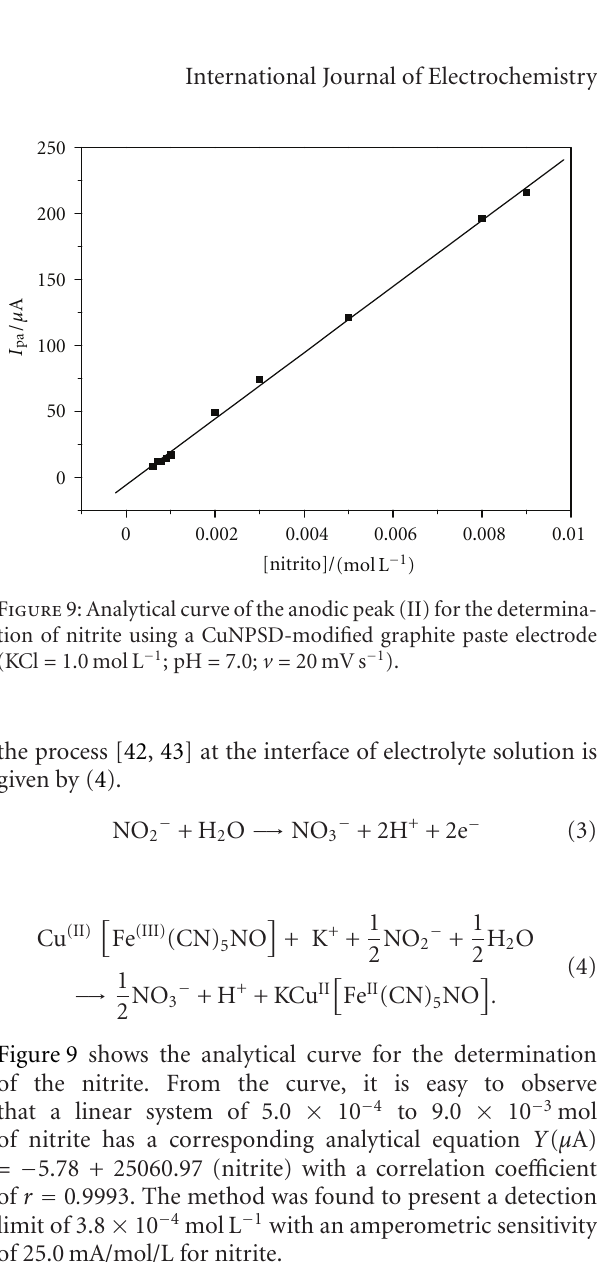
Figure 8: Cyclic voltammograms obtained for the CuNPSD- modified graphite paste electrode in the presence of di ff erent con- centrations of nitrite (5.0 × 10 − 5 to 9.0 × 10 − 3 molL − 1 , KCl = 1.0molL − 1 ; pH = 7.0; v = 20 mVs − 1 ).